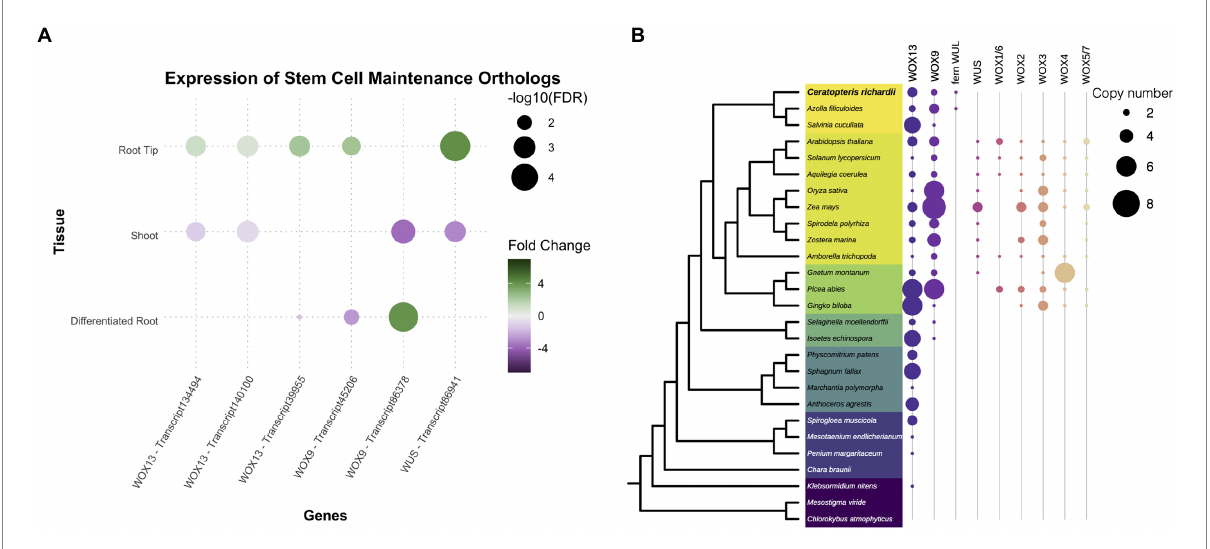
FIGURE 4 Conservation of genes involved in stem cell maintenance. (A) Expression of Ceratopteris ortholog WUSCHEL homeobox-containing (WOX) genes in the different segments. (B) Schematic representation of the presence and absence of orthologs for the different WOX clades throughout plant